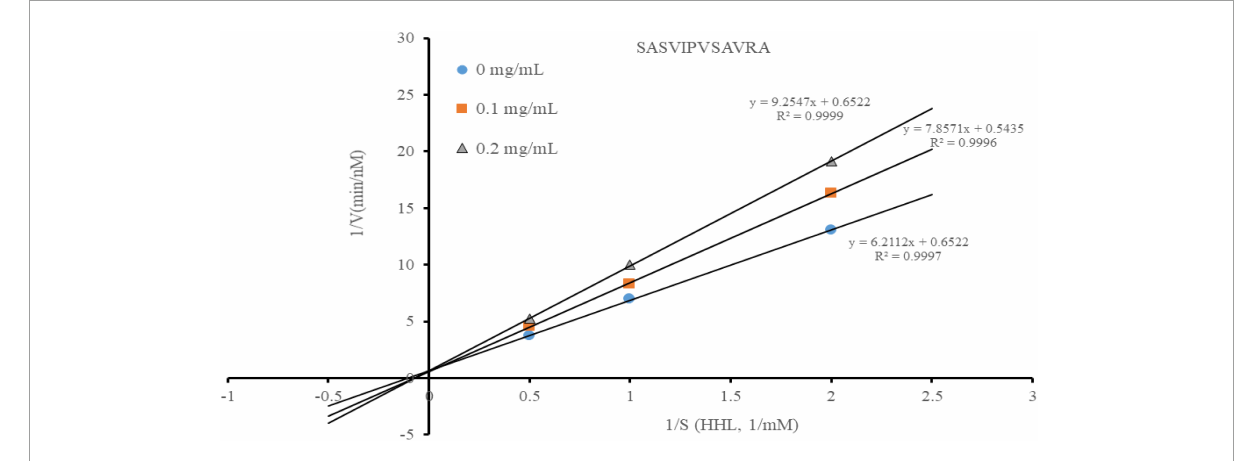
FIGURE4 Line weaver-Burke plot of ACE activity in the presence of the